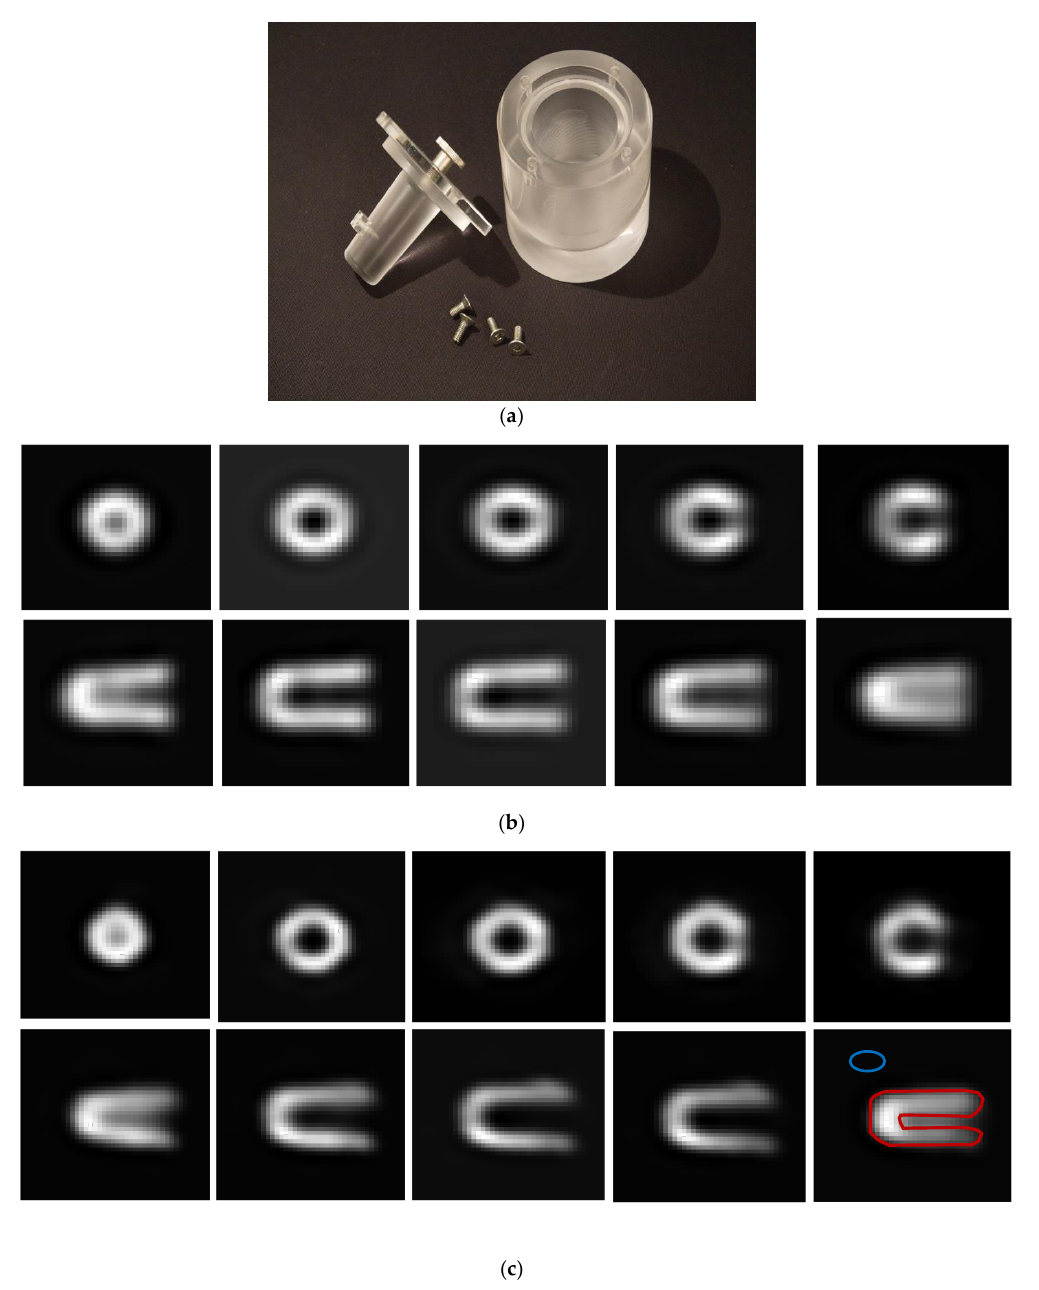
Figure 4. Custom-made cardiac phantom; ( a ) the phantom; ( b ) example images from Alcyone, slices are in the short axis (upper row) and long axis (lower row) views; ( c ) example images from Discovery; slices are in the short axis (upper row) and long axis (lower row). In the lower right image in ( c ), the ROIs covering the phantom (in red) and the background (in blue) are shown as an example to show where ROIs have been selected for numerical analysis (i.e., uniformity, SBNR, and